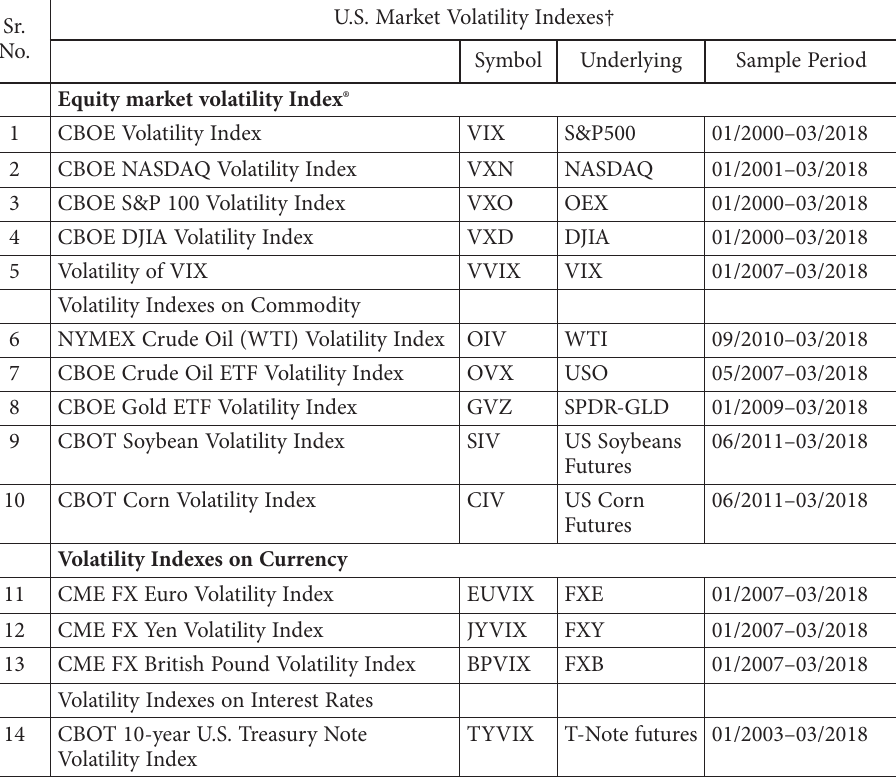
Table A.1. Description of various market volatility indices Sr. No.